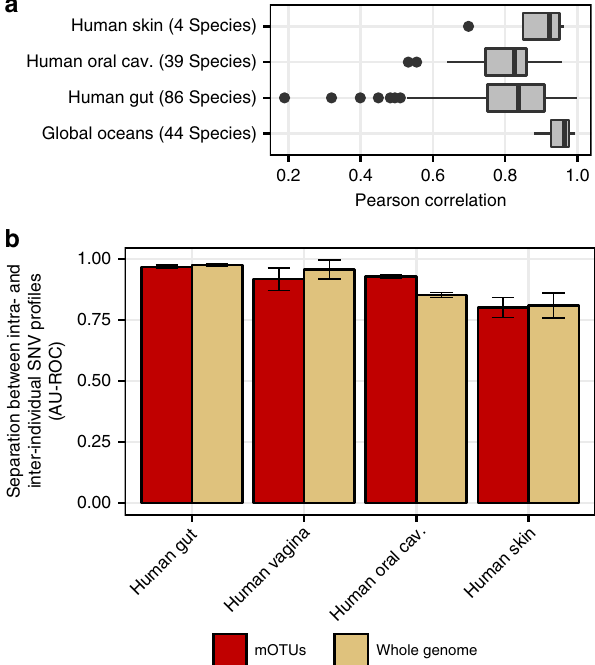
Fig. 5 Marker gene-based SNV pro fi les are comparable to those using whole genomes. a Pearson correlation coef fi cients for MG- and genome- based SNV pro fi les across species and biomes in the HMP ( N = 2807) and ocean dataset ( N = 139). Median correlations (Pearson ’ s r) are shown as horizontal lines and interquartile ranges as boxes. Whiskers extend at most 1.5 times the interquartile range. b Intra- and inter-individual distances of SNV pro fi les were compared using the area under the receiver operating characteristic curve (AU-ROC) to determine the degree of individuality of microbial strain populations for different human body sites (see also Supplementary Figure 17). Error bars delineate 95% con fi dence intervals after bootstrapping. Source data are provided as a Source Data fi